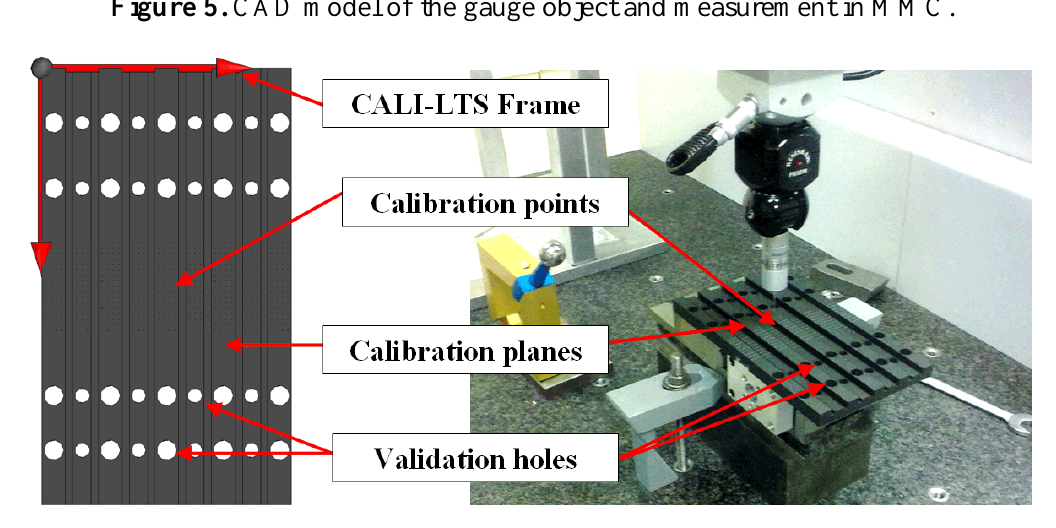
Figure 5. CAD model of the gauge object and measurement in